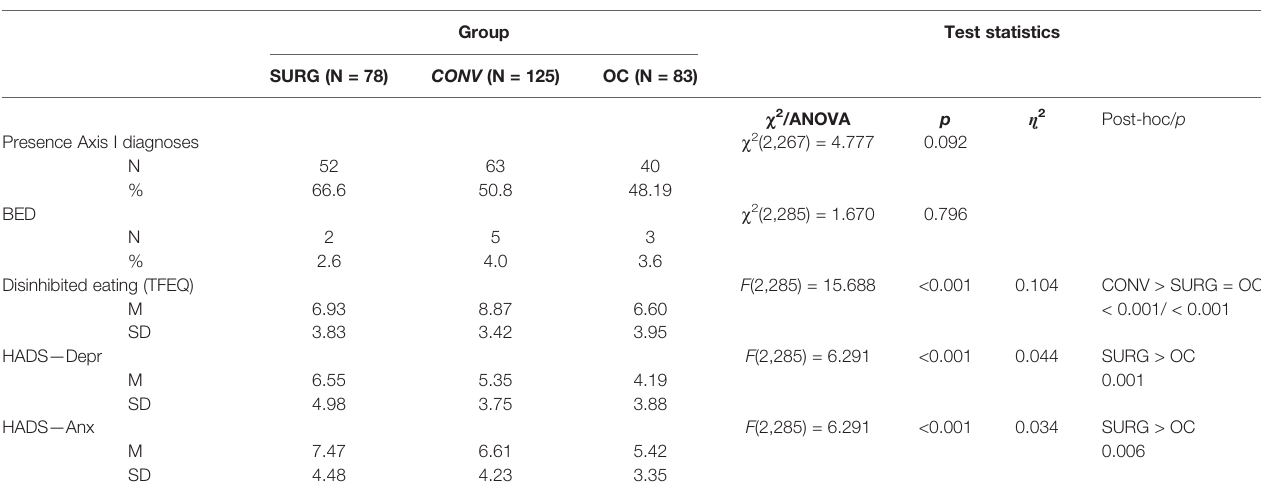
TABLE 2 | Psychopathology compared between groups.